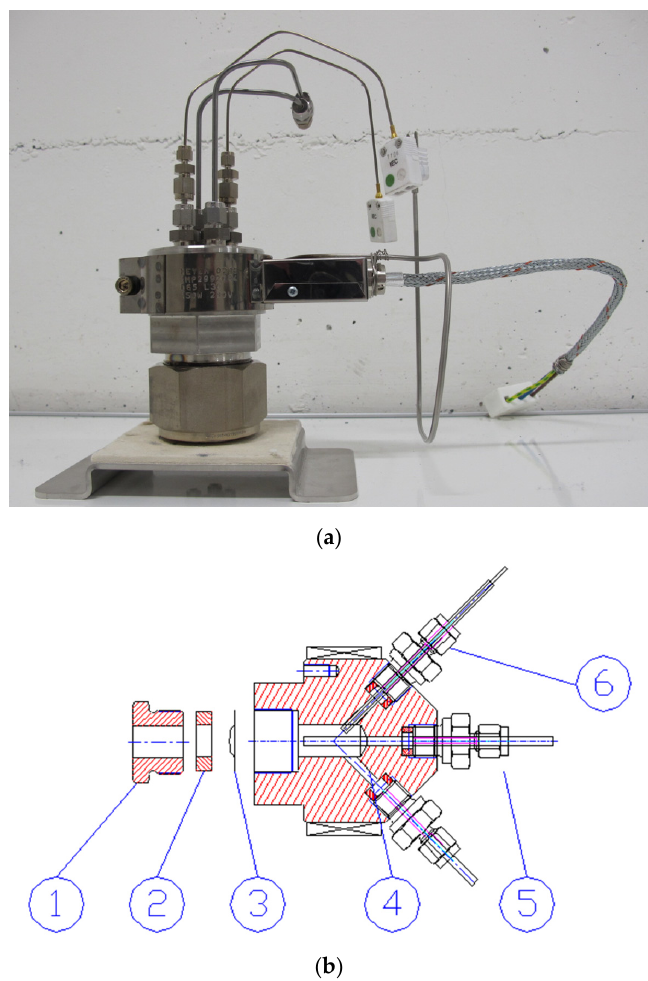
Figure 4. Autoclaves used with the recirculation loop. ( a ) Autoclave used for gamma radiolysis experiments. ( b ) Irradiation cell for ion beam experiments, where (1) is a closing nut, (2) ceramic washer, (3) metallic foil window; (4) water outlet line; (5) water inlet line; (6) temperature sensor.